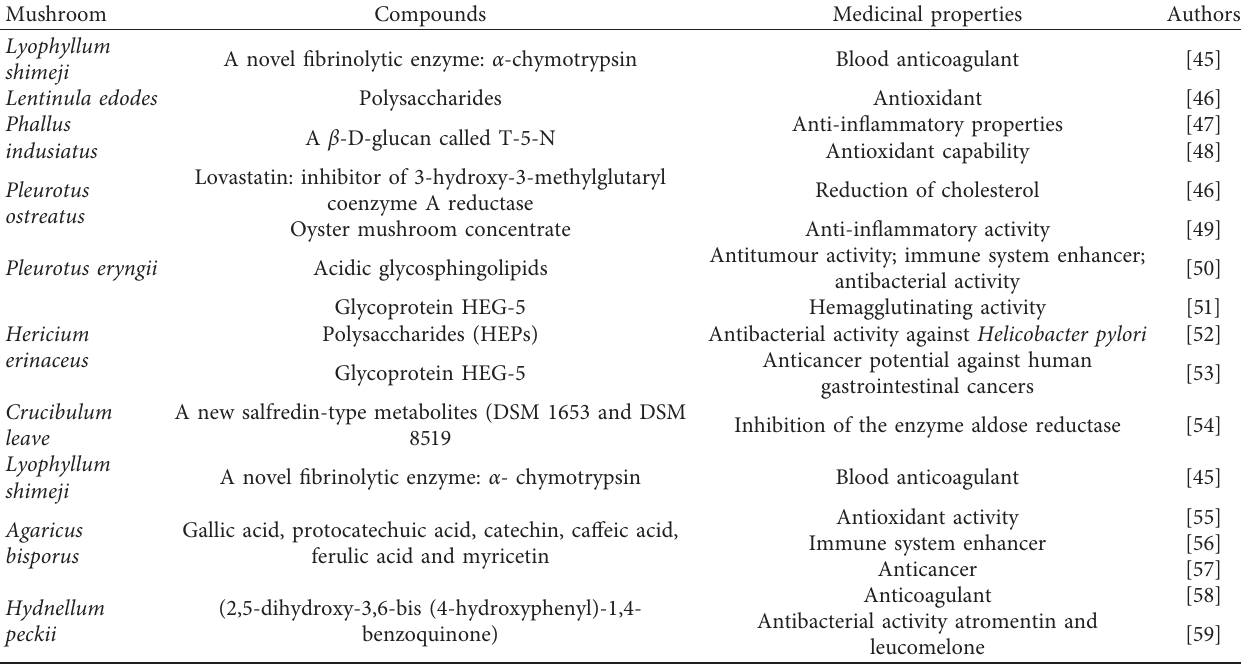
Table 2: Medicinal values of some important mushrooms.